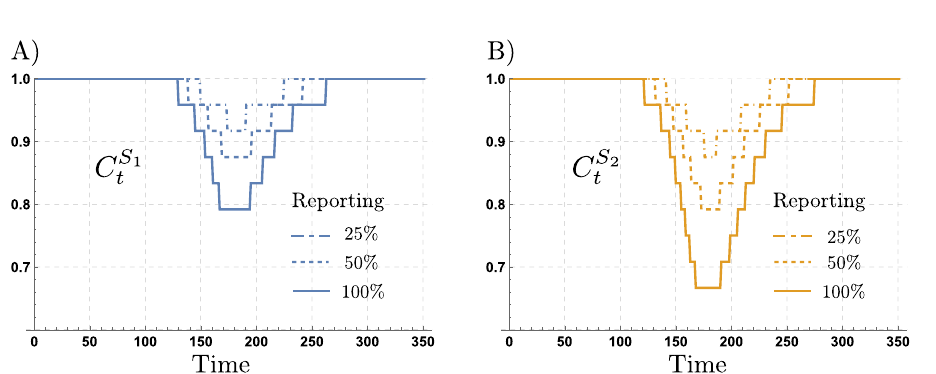
Figure 6. Risk-group contact rates for different reporting levels. Risk-taker and risk-evader contact rates for levels of reporting of 25% , 50% and 100% . The risk-evaders’ contact rate is more sensitive to changes in the reporting levels, compared to risk-takers’ contact rate. The set of parameters used are those in Table